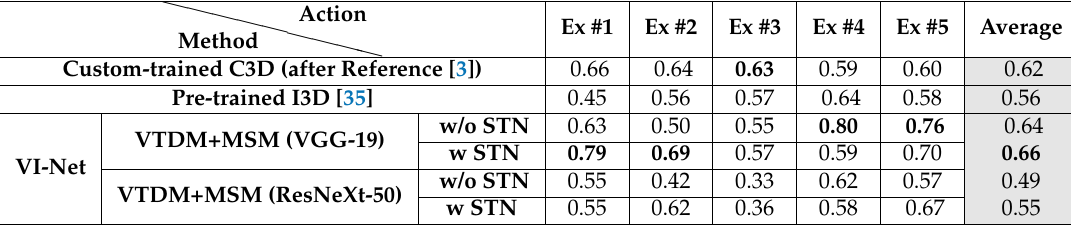
Table 7. Comparative results on the single-view KIMORE dataset. The bold numbers show the best result for each action